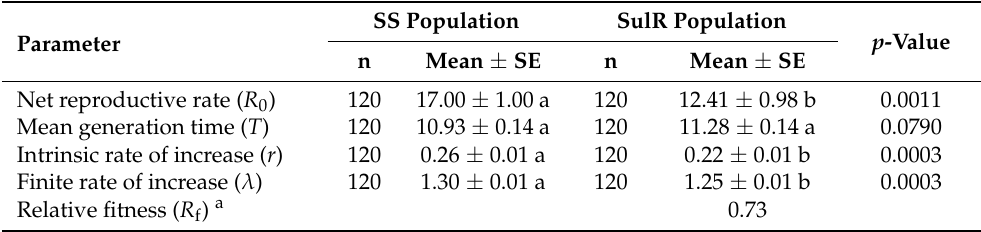
Table 3. Life table parameters of sulfoxaflor-susceptible (SS) and sulfoxaflor-resistant (SulR) Sitobion miscanthi